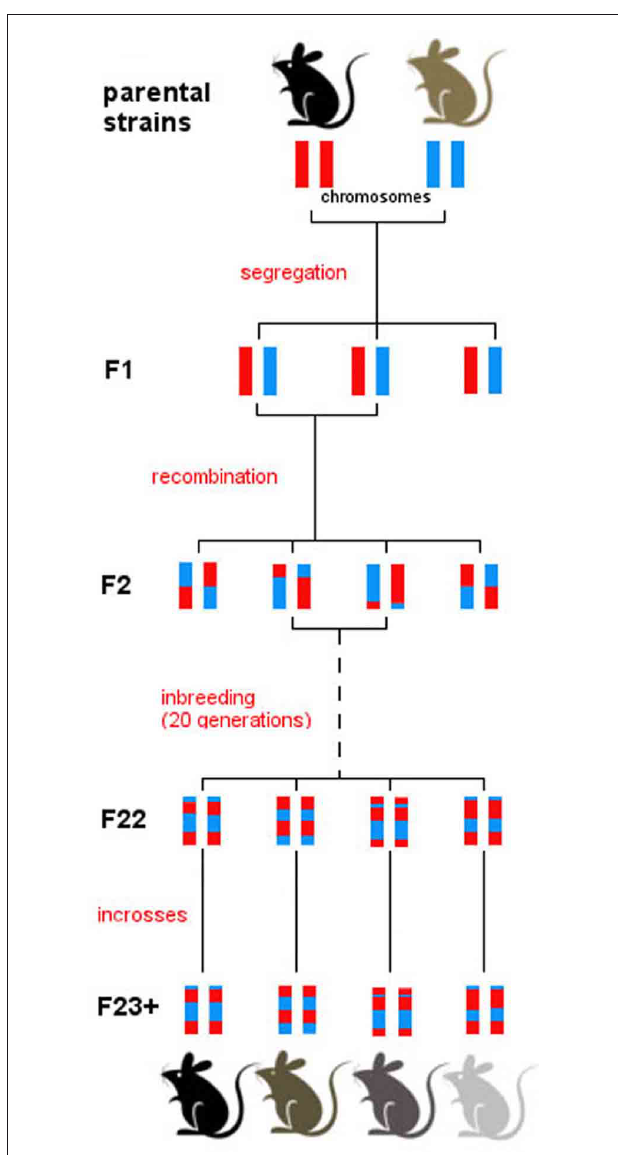
FIGURE 1 | Derivation of the BXD set. All BXD lines are derived from two parental strains, namely C57Bl/6J and DBA/2J. Following a cross between the two, the F1 generation consists of genetically identical individuals that inherited one chromosome from each parental strain. Intercrosses were then carried out between F1 individuals, generating recombination in the F2. Patterns of recombination were frozen with 20 generations of sib-matings, which resulted in almost complete homozygosity in generation F23. From then on, breeding was continued by full-sib matings within every line, and individuals were monitored to ensure consistency in the genotype of each line over time. After generation F23, therefore, each line represents a unique mosaic of C57Bl/6J and DBA/2J alleles; there is extensive variation between line, and virtually no genetic variation between individuals of one